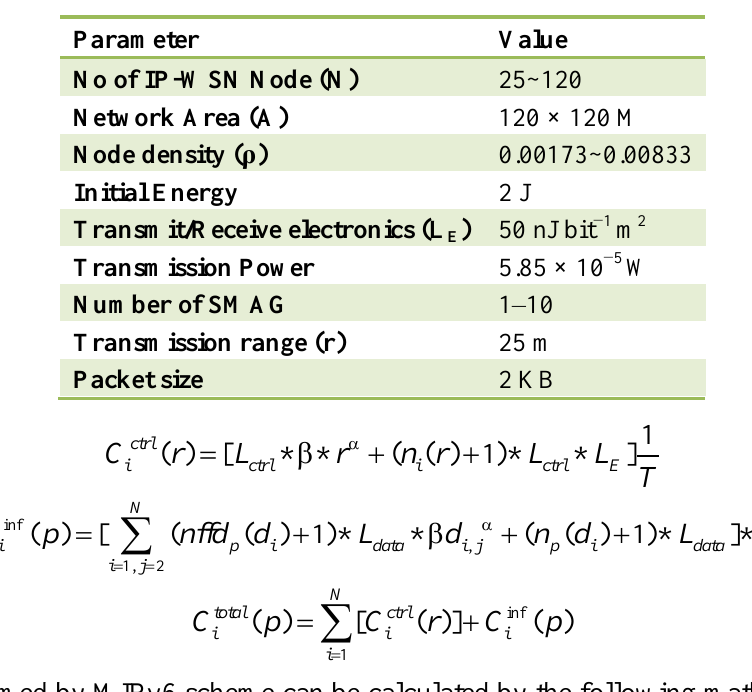
Table 2. Parameter